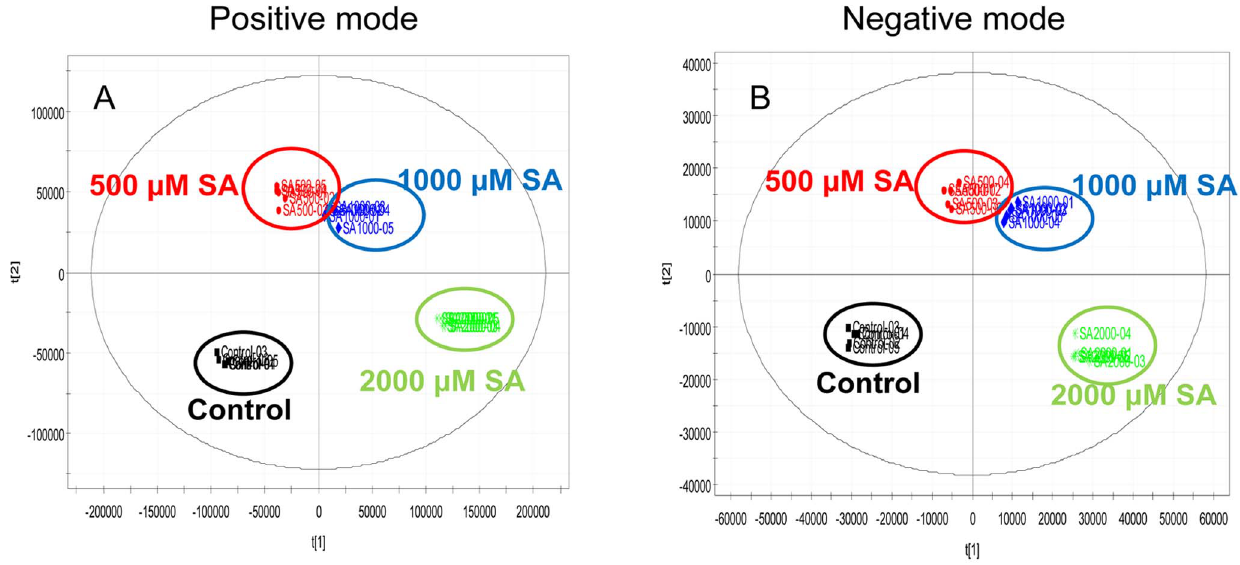
Figure 7. OPLS-DA score plot. OPLS-DA score plots of control (black), 500 m M SA (red), 1000 m M SA (blue), and 2000 m M SA (green)-treated adventitious roots analyzed by UPLC-ESI-MS in positive (A) and in negative (B) mode.